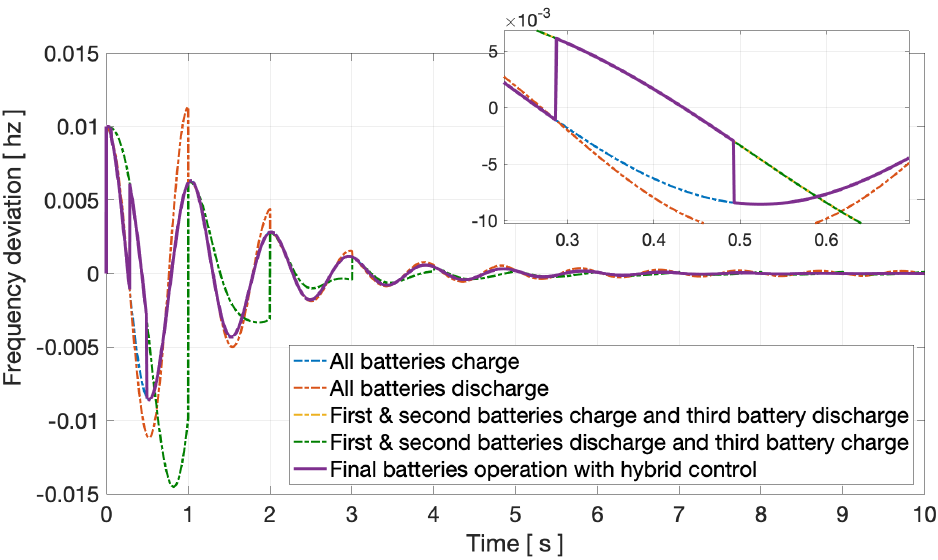
Figure 5. Frequency deviations of the generator number one in the first area for different scenarios and hybrid control final decision.